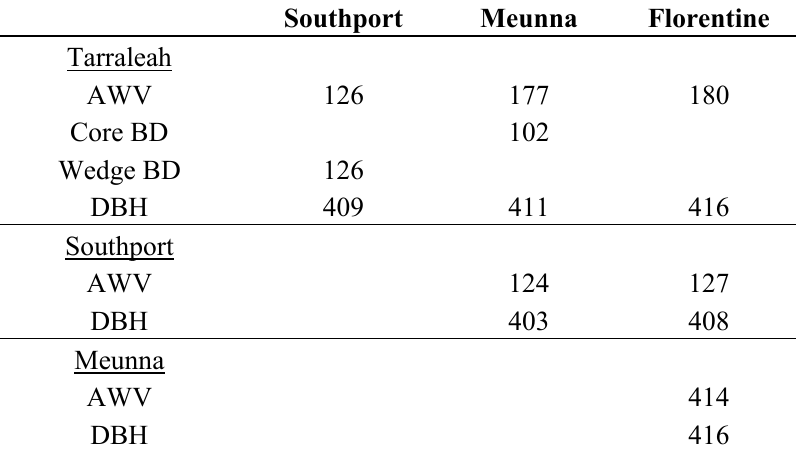
Table 3. Number of families in common between the four Eucalyptus nitens progeny trials that were assessed for acoustic wave velocity (AWV), basic density (BD) and diameter at breast height (DBH; 1.3